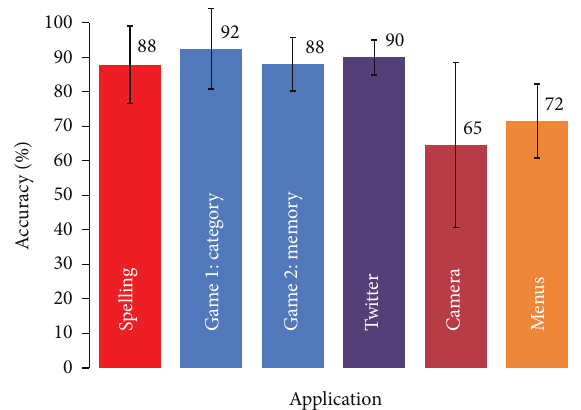
Figure 4: Average accuracies for the first session achieved by preliminary test users for the five tasks and for switching between tasks